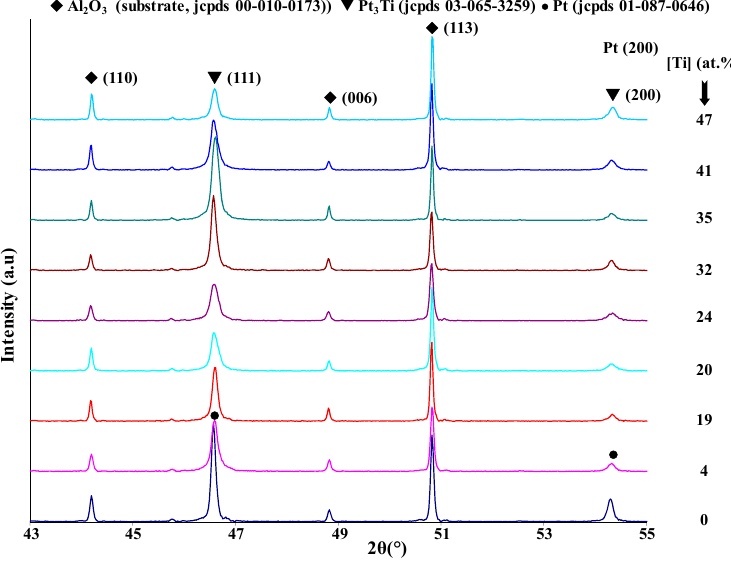
Figure 3. XRD patterns of the Pt–Ti films deposited on alumina pellets after annealing treatment in air at 1173 K during two hours and for different titanium concentrations.